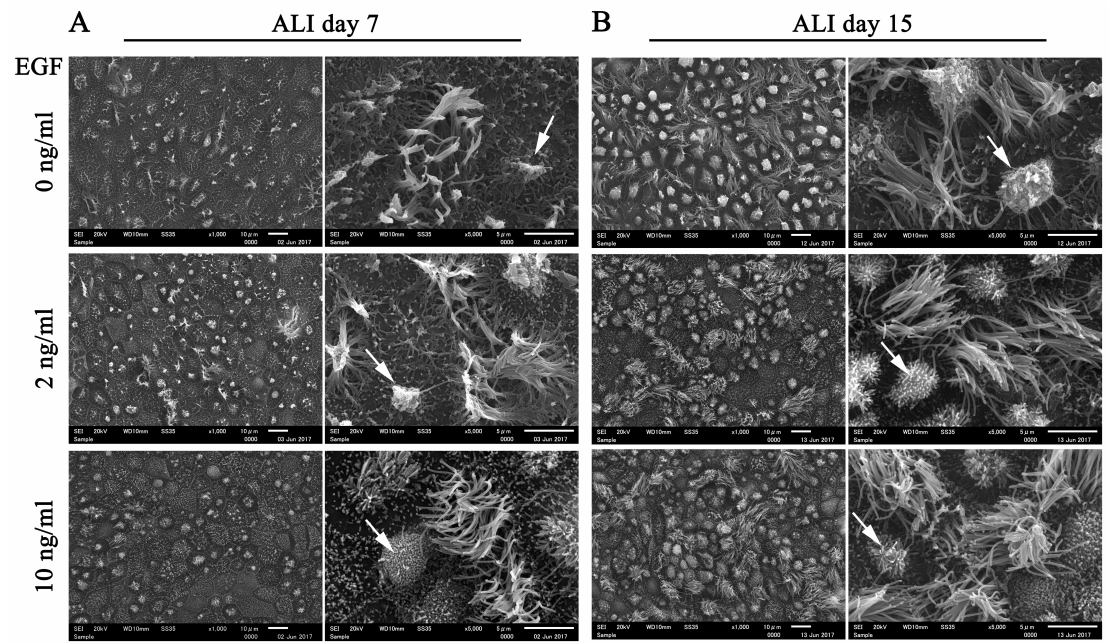
Figure 6. E ff ects of epidermal growth factor (EGF) on the morphology of di ff erentiated cells. ( A , B ) FTECs were incubated with 4 Mix medium, supplied with di ff erent concentrations of EGF, as well as 2 ng / mL E2 to induce di ff erentiation. Cells were fixed and observed by scanning electron microscopy (SEM) on ALI culture days 7 and 15. Scale bars: left panel, 10 µ m; right panel, 5 µ